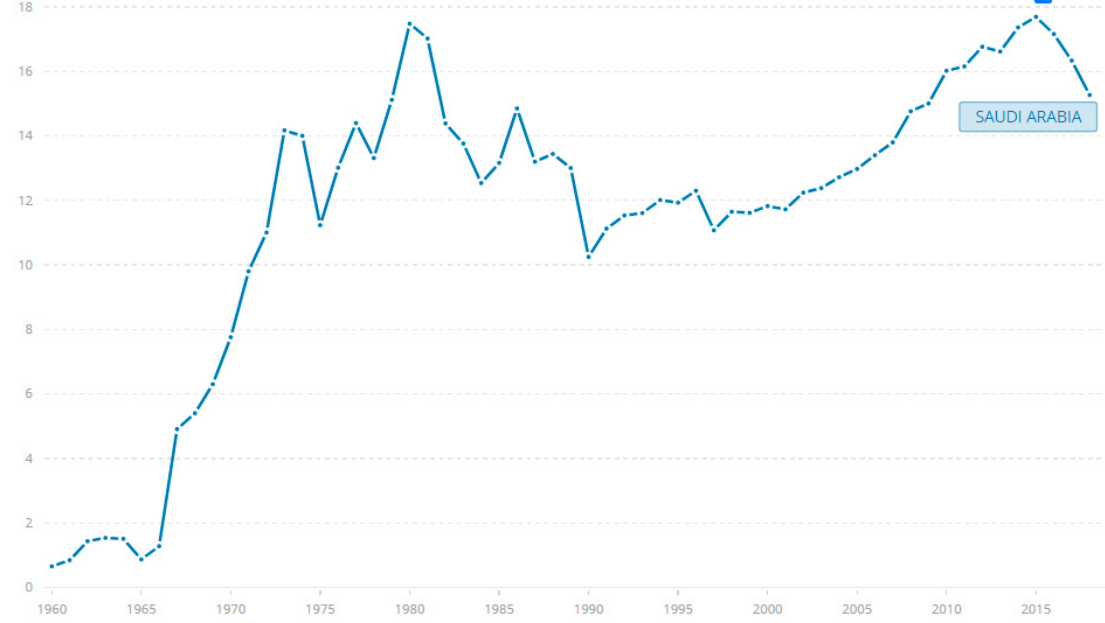
Figure 1. CO 2 emissions—Saudi Arabia (Source: World Development Bank).